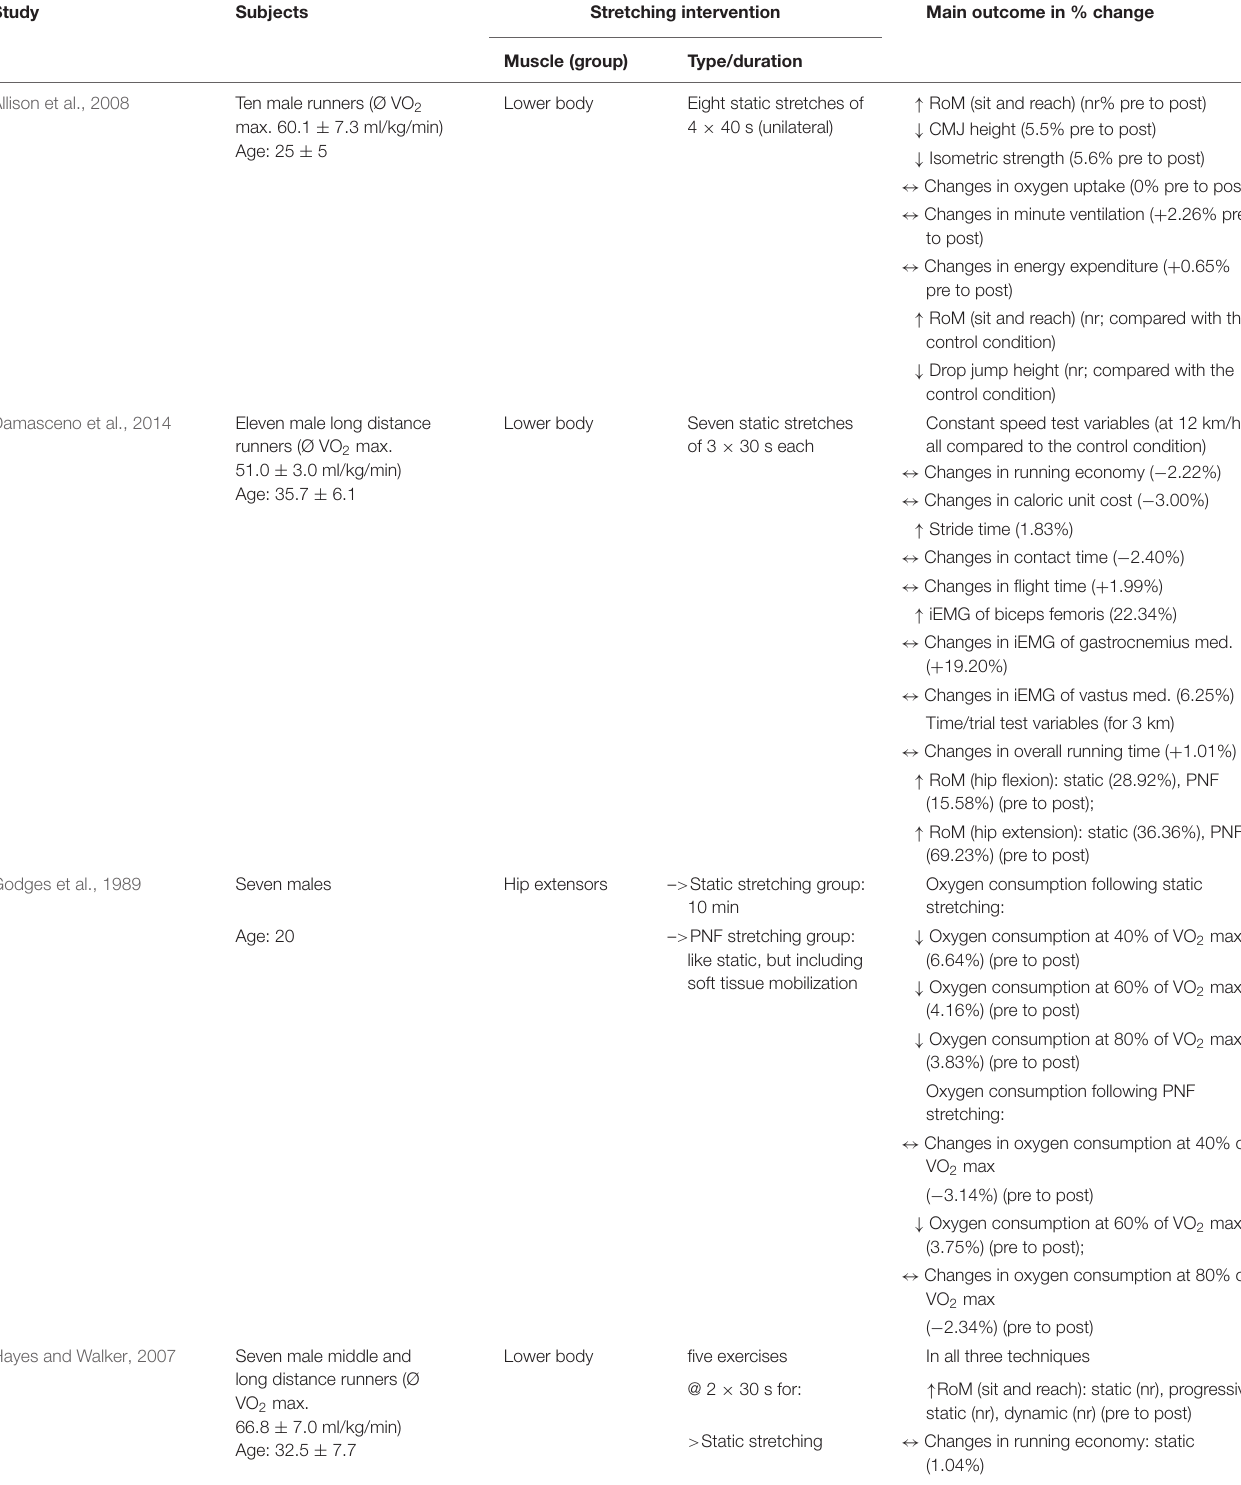
TABLE 1 | Summary of the results and summary of the participants and intervention characteristics of the studies which investigated the acute effects of stretching on running economy and running performance. Study Subjects Stretching intervention Main outcome in % change Muscle (group) Type/duration ↑ RoM (sit and reach) (nr% pre to post) Allison et al., 2008 Lower body Eight static stretches of 4 × 40 s (unilateral) ↓ CMJ height (5.5% pre to